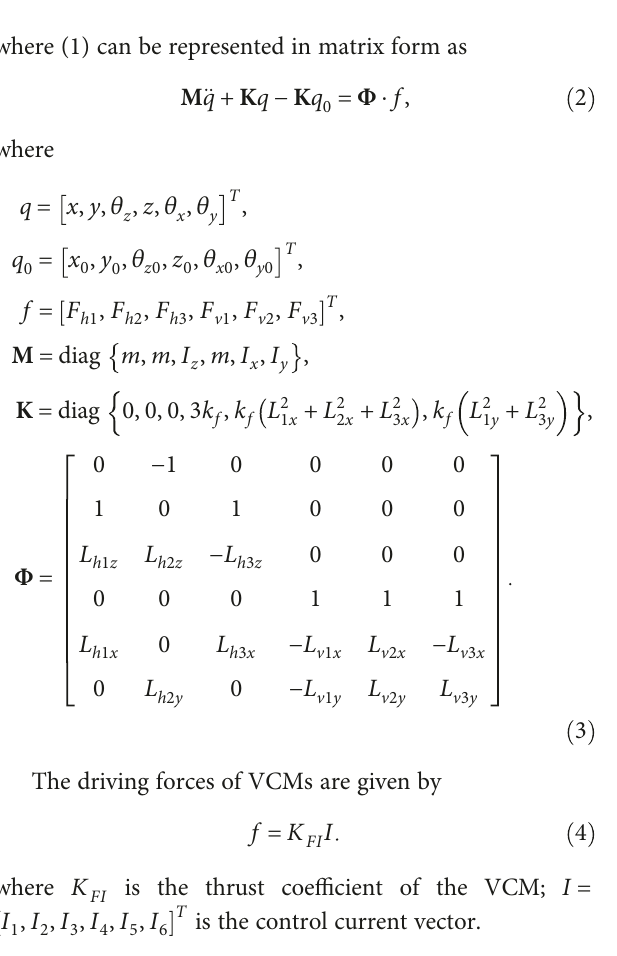
Figure 2: Scheme of active vibration isolation